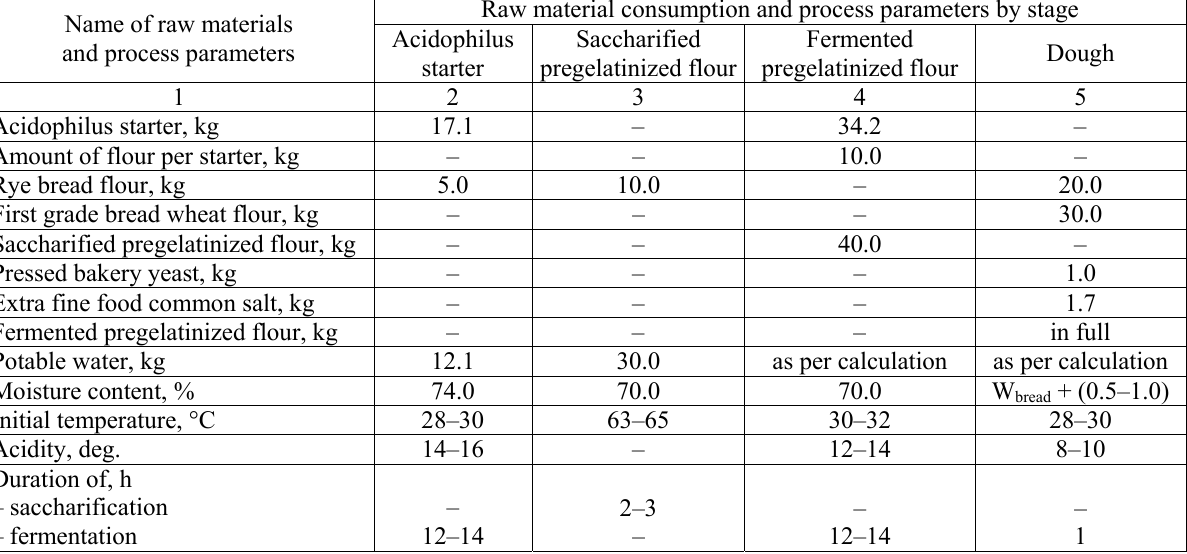
Table 1 . Formulation and mode of making dough on the basis of the pregelatinized flour fermented using a liquid acidophilic starter Name of raw